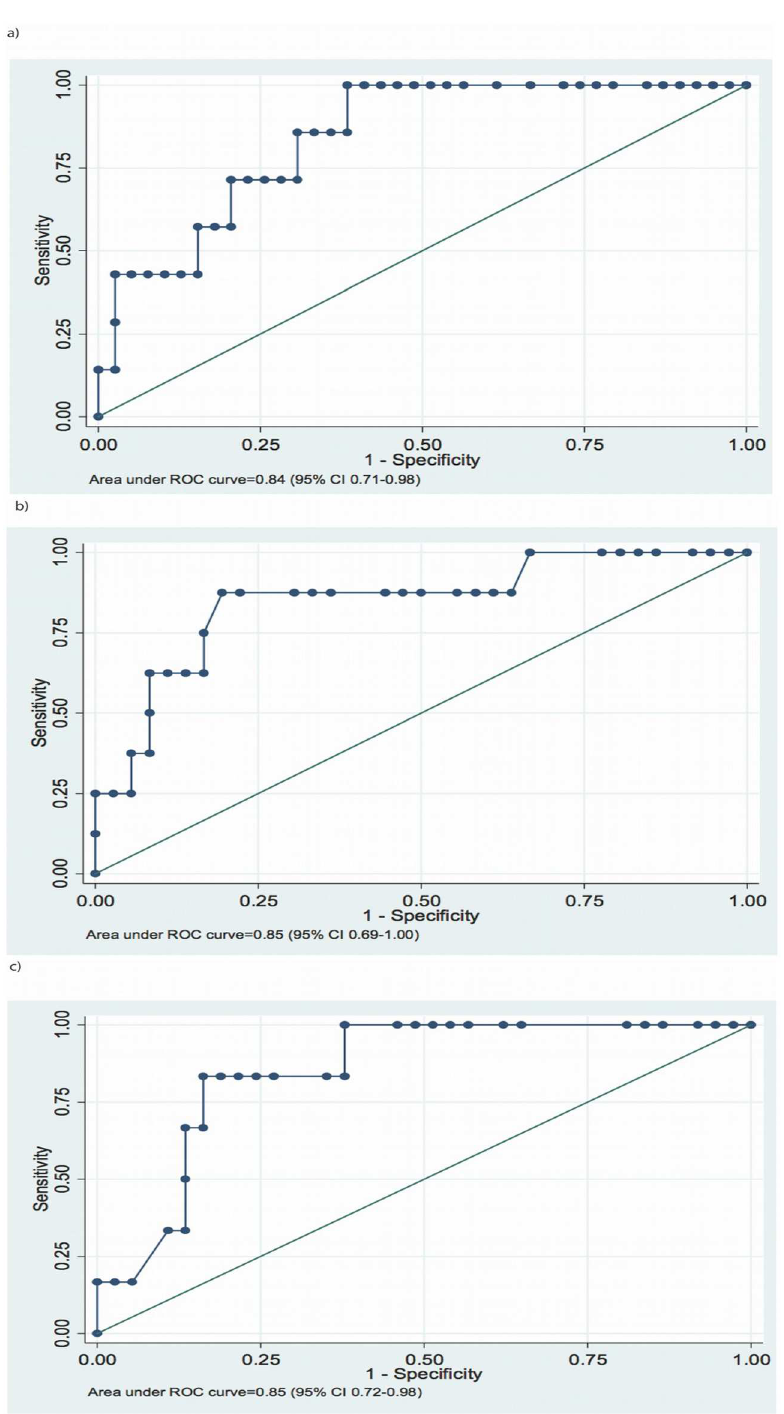
Fig 4. Receiver-operating characteristic curves for a) right atrial area, b) right ventricular end-diastolic diameter, measured in the apical 4-chamber view, and c) the ratio of the right ventricular to the left ventricular end- diastolic diameter (in the 4-chamber apical view) by echocardiography, for separation of patients who died from those who survived during the follow-upperiod.